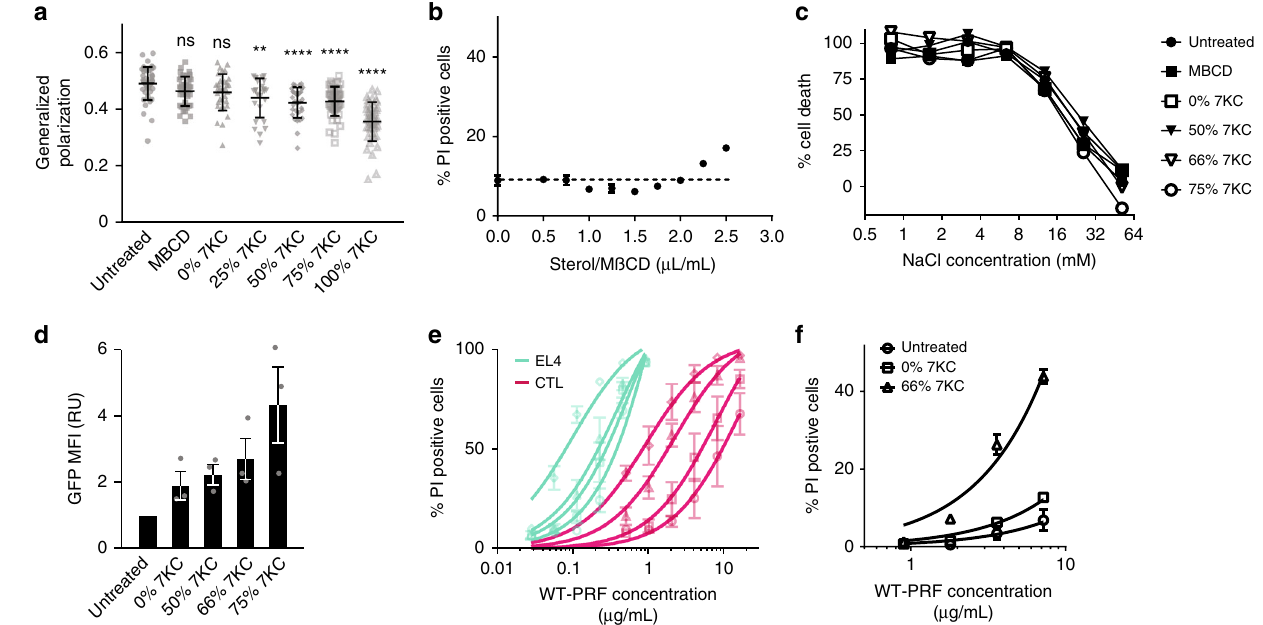
Fig. 4 Reduced membrane order sensitizes cells to perforin lysis. a Lipid order in the CTL plasma membrane for cells treated with different ratios of 7KC/ cholesterol, as measured by GP values 26 (see Methods). Data points represent individual cells, measured in three independent experiments and are overlaid with mean ± s.e.m.; statistical signi fi cance was assessed using ANOVA with Dunnett ’ s post-hoc analysis, where ‘ ns ’– not signi fi cant, ** p < 0.01, **** p < 0.001. b Determination of a non-cytotoxic concentration of 7KC. A total of 5 × 10 5 CTLs were treated with increasing amounts of a 75% 7KC/25% cholesterol mix in MßCD, and cell death assessed by propidium iodide (PI) staining. A total of 2.25 µ L/mL was chosen as the optimal concentration for following cholesterol loading experiments. Data points show mean ± s.e.m. of three independent experiments with the dotted line marking background cell